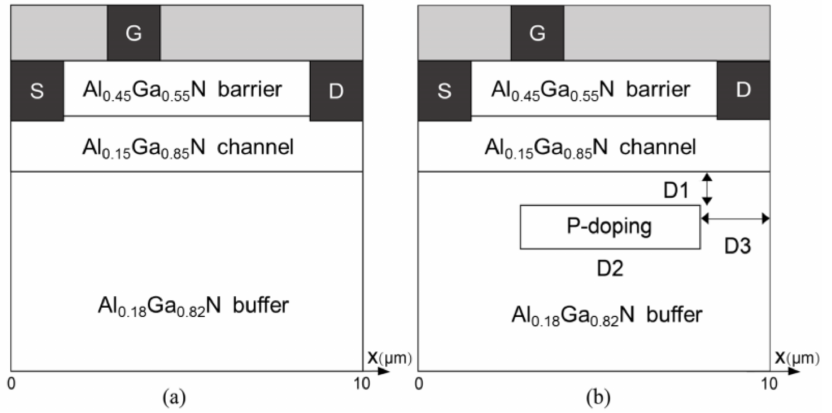
Figure 1. The schematic diagram of ( a ) a conventional back-barrier structure, ( b ) the proposed structure with the local p-doped